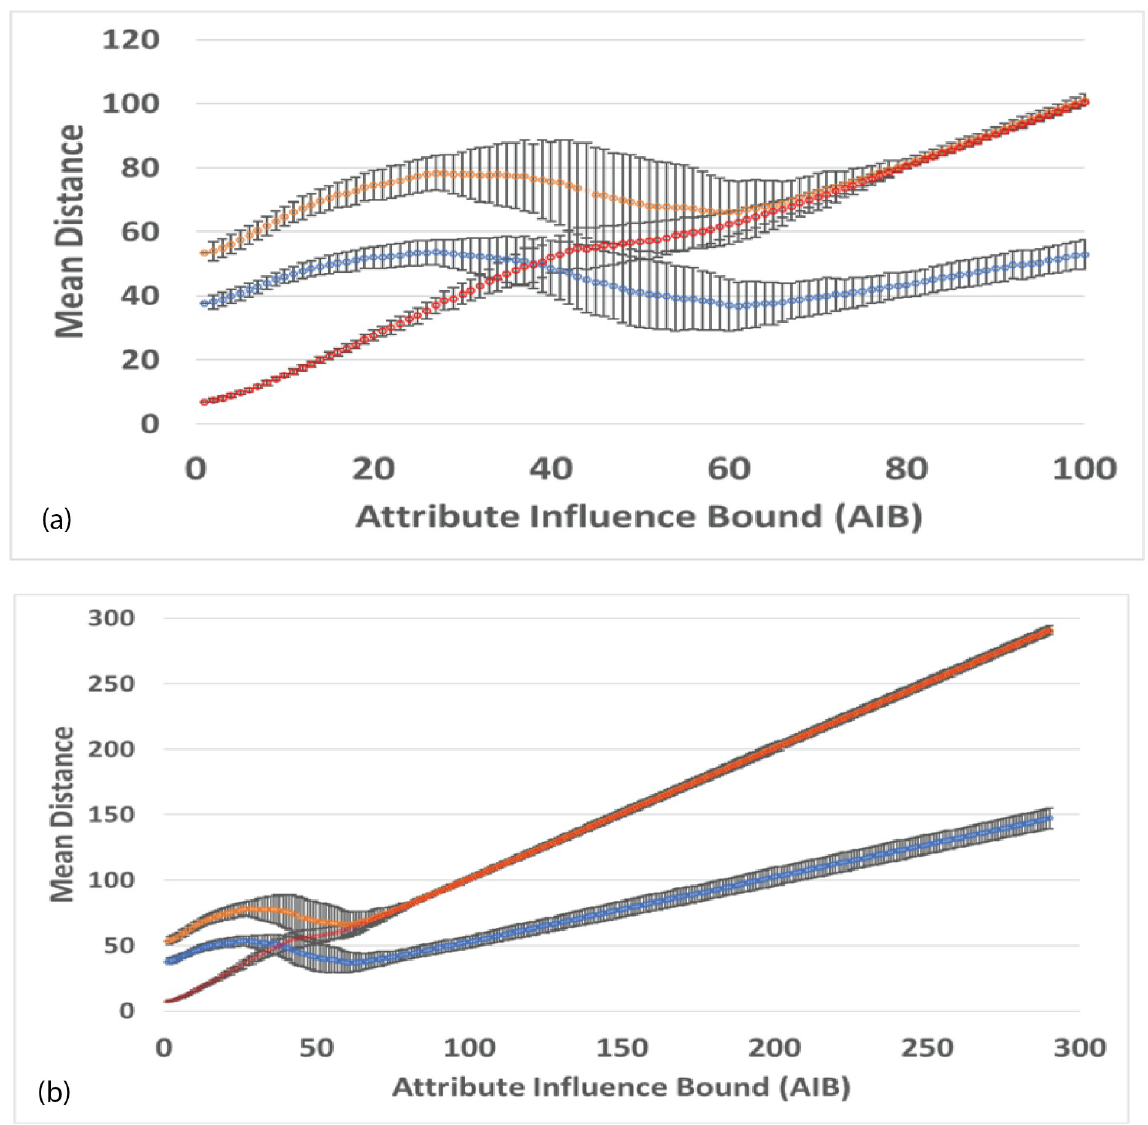
Fig 16. Mean distances at the end of a simulation with standard deviations. Orange = Mean Distance between Agents; Blue = Mean Distance to Origin; Red = MDCN Mean Distance to Closest Neighbor. a) AIB from 0 to 100. b) AIB from 0 to 280.